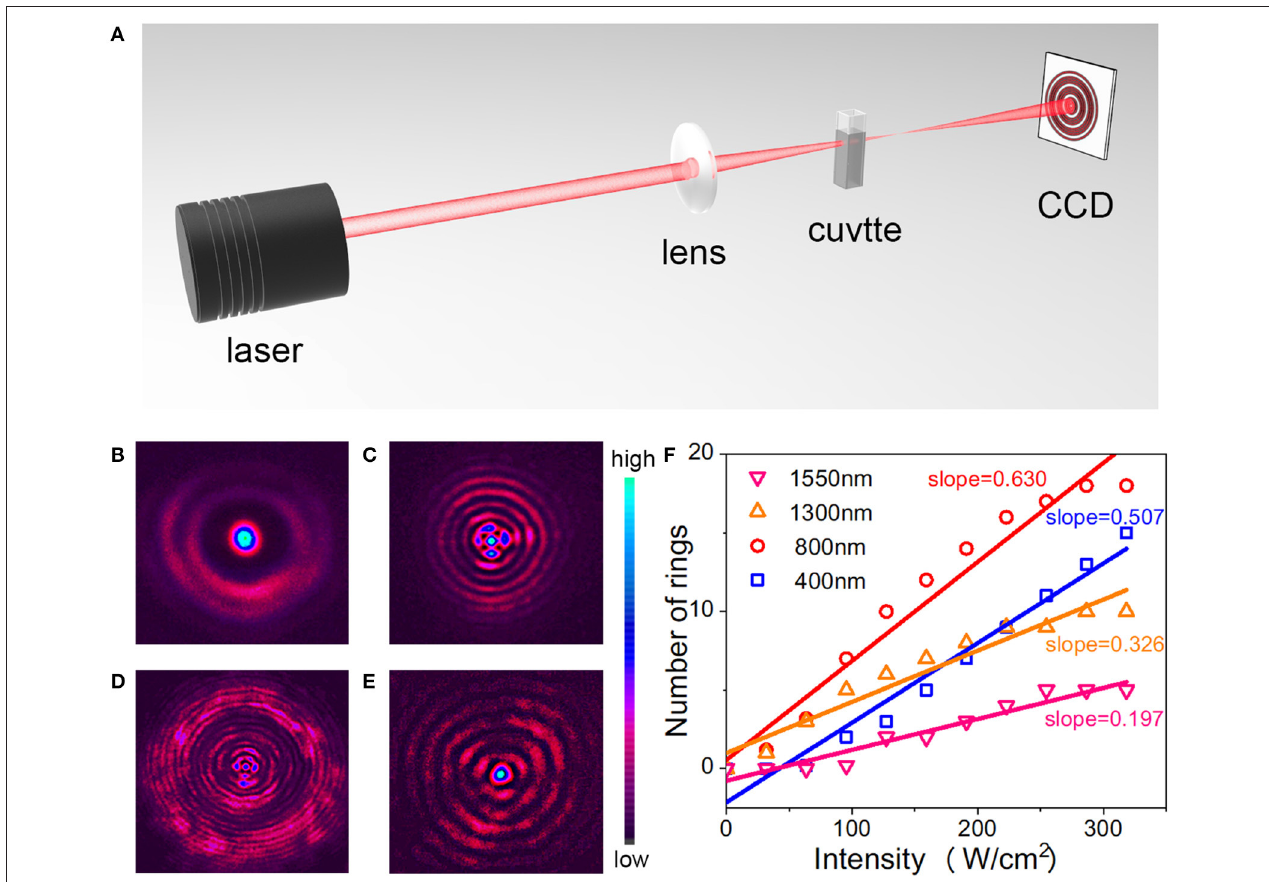
FIGURE 2 | (A) Experimental setup for SSPM measurements. (B–E) SSPM patterns at (B) 1,550nm, (C) 1,300nm, (D) 800nm, (E) 400nm. (F) Numbers of diffraction rings vs. incident beam intensity at four wavelengths.